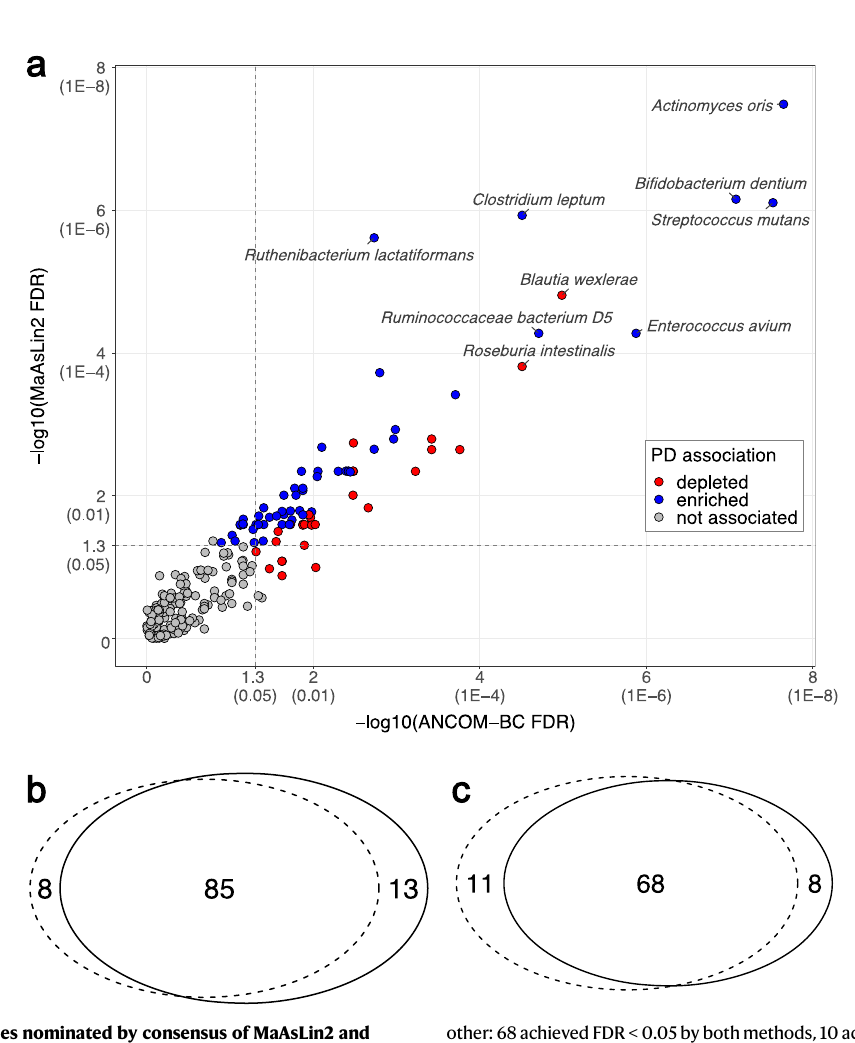
other:68achievedFDR<0.05bybothmethods,10achievedANCOM-BCMaAsLin2 FDR<0.05byMaAsLin2andFDR ≤ 0.1byANCOM-BC,and6achievedFDR<0.05by ANCOM-BC and FDR ≤ 0.1 by MaAsLin2. Blue: abundance is signi fi cantly elevated in PD.Red:abundanceissigni fi cantlyreducedinPD.Gray:notsigni fi cantlyassociated with PD. Vertical and horizontal dashed lines denote points on X and Y axes that correspond to FDR=0.05. b , c Venn diagrams summarizing the overlap of species detected by MaAsLin2 (dotted circle) and ANCOM-BC (solid circle) at FDR ≤ 0.1 ( b ), and at FDR<0.05 ( c